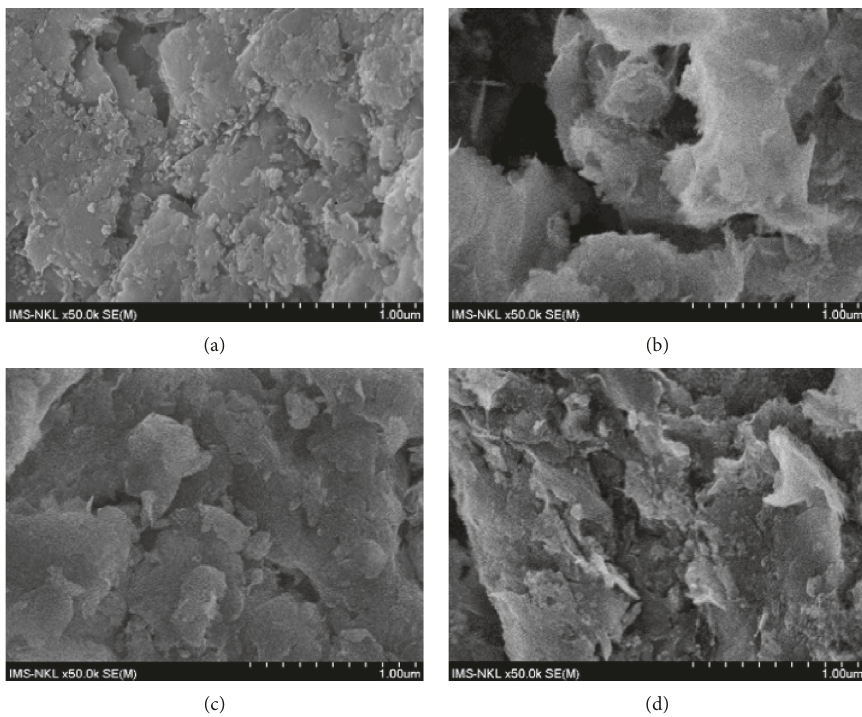
Figure 8: SEM images of Fe-B (a), Fe-B after the As(V) adsorption (b), Al-B (c), and Al-B after the As(V) adsorption (d).